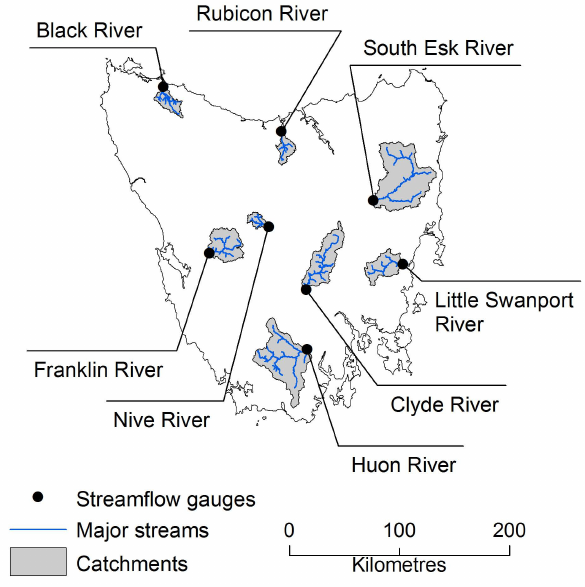
Fig. 3. Catchments reported by this